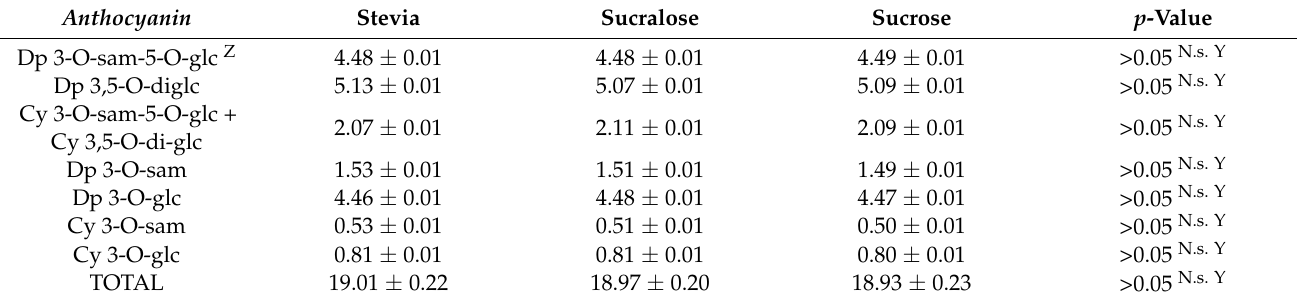
Table 2. Anthocyanin composition (mg/100mL) of the maqui-citrus